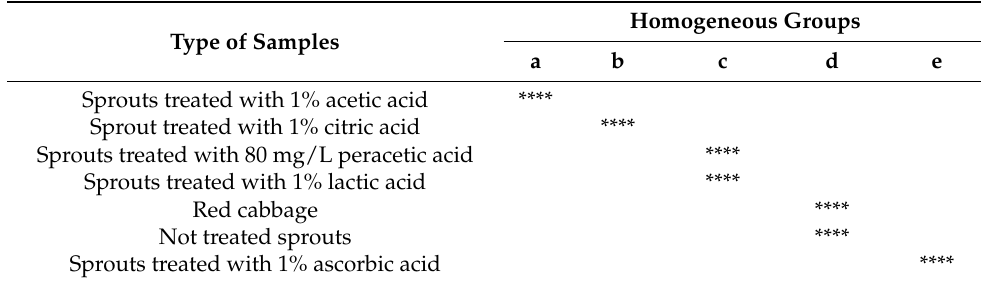
Table 4. Group homogeneity test ( α = 0.05) comparing the effect of the organic acids used on the antioxidant properties (ABTS) of red cabbage sprouts not subjected to storage.